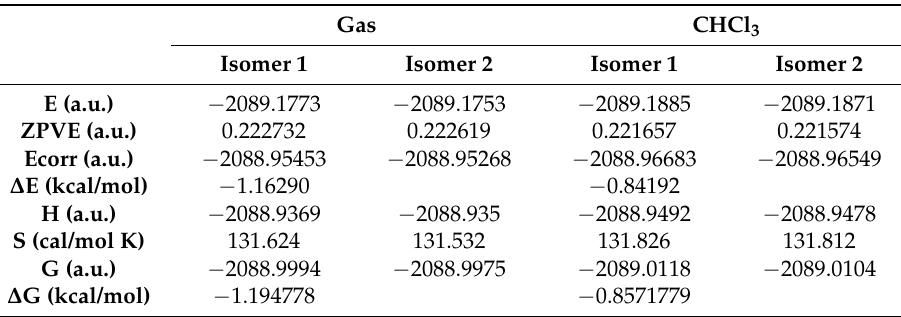
Table 2. Energies and thermodynamic parameters of the studied isomers.